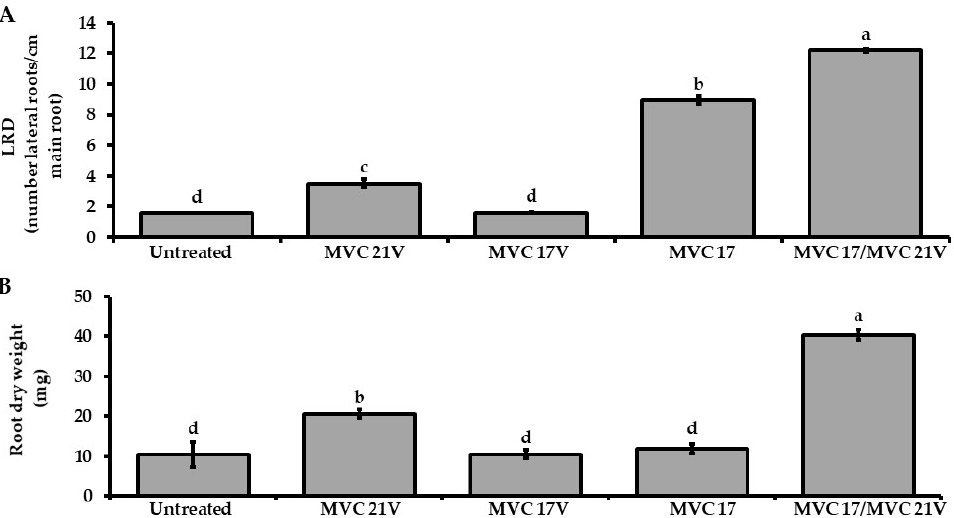
Figure 3. Effect of Pantoea agglomerans MVC 21 volatile organic compounds (VOCs) on the plant growth-promoting efficacy of Pseudomonas (Ps.) putida MVC 17. Lateral root density (LRD) ( A ) and root dry weight ( B ) of tomato seedlings inoculated with Ps. putida MVC 17 were assessed after 10 days of exposure to P. agglomerans MVC 21 VOCs. Untreated. tomato seedlings exposed to agar medium only; MVC 21V. tomato seedlings exposed to P. agglomerans MVC 21 VOCs; MVC 17V. tomato seedlings exposed to Ps. putida MVC 17 VOCs; MVC 17. tomato seedlings inoculated with Ps. putida MVC 17; MVC 17/MVC 21V. tomato seedlings inoculated with Ps. putida MVC 17 and exposed to P. agglomerans MVC 21 VOCs. Columns represent mean ± standard error values of twelve replicates (tomato seedlings) are reported for each treatment. Data from two independent experiments were pooled. Different letters indicate significant differences among treatments according to Tukey´s test ( α = 0.05).